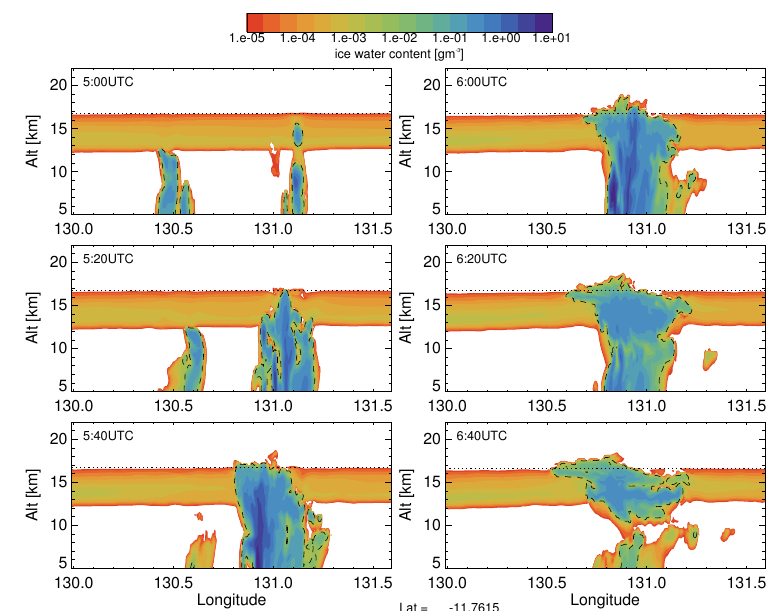
Figure 5. IWC cross sections between 05:00 and 06:40UTC. The dashed line represents the 0.01gkg − 1 ice mixing ratio, representing the cloud boundary, and the dotted line indicates the simulated cold point tropopause.